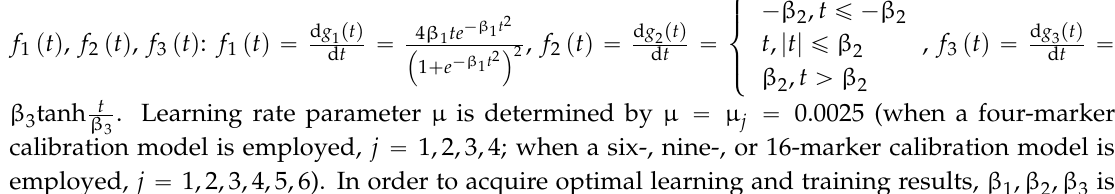
without considering error compensation. The blue “ ∗ ” symbols represent gaze points estimated